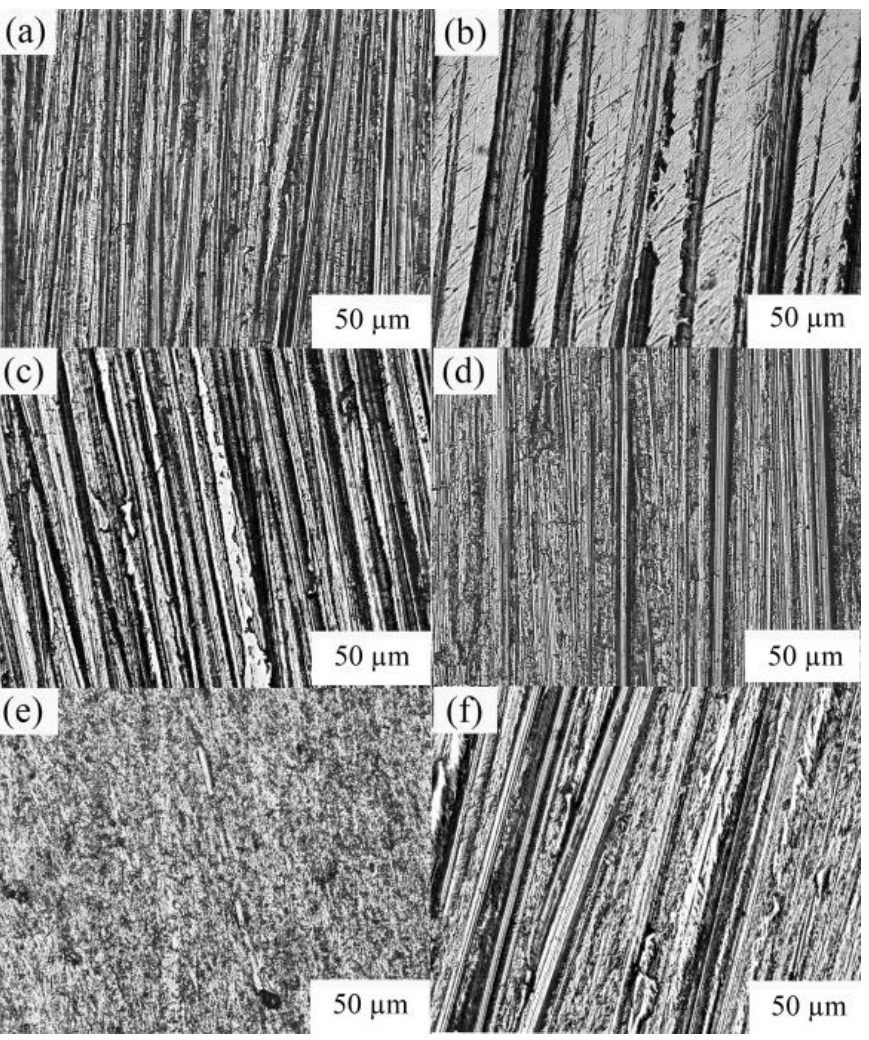
Figure 10. Surface morphologies of copper and aluminum alloy workpieces (( a ) copper alloy before polishing; ( b ) copper alloy after polishing; ( c ) copper alloy after polishing without abrasive materials; ( d ) aluminum alloy before polishing; ( e ) aluminum alloy after polishing; and ( f ) aluminum alloy after polishing without abrasive materials).